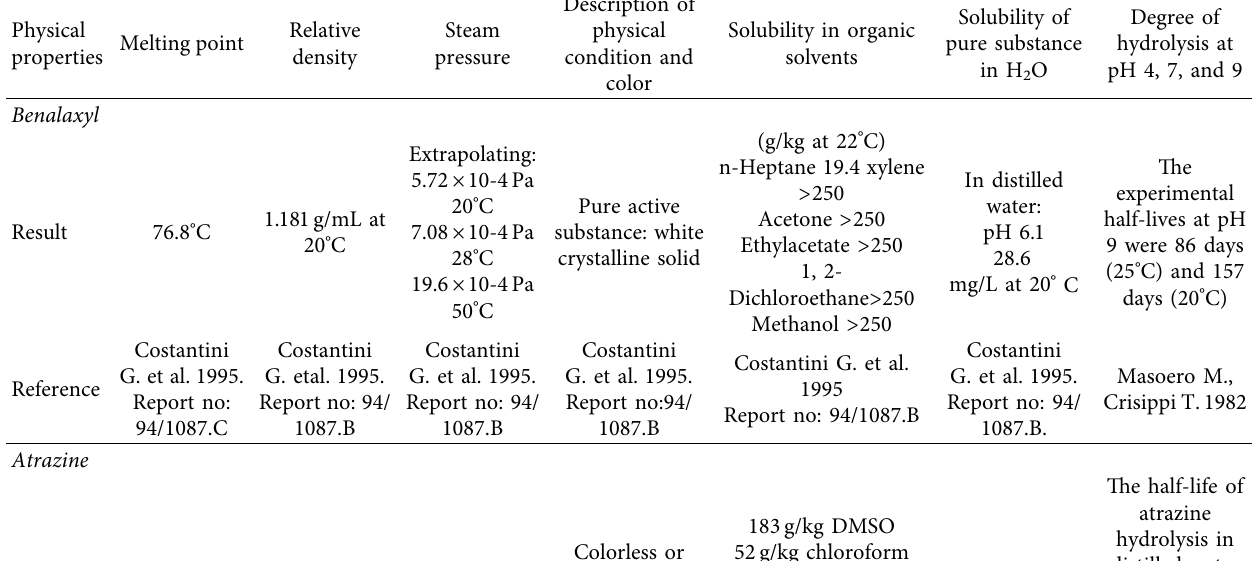
Table 4: Physical properties of benalaxyl and